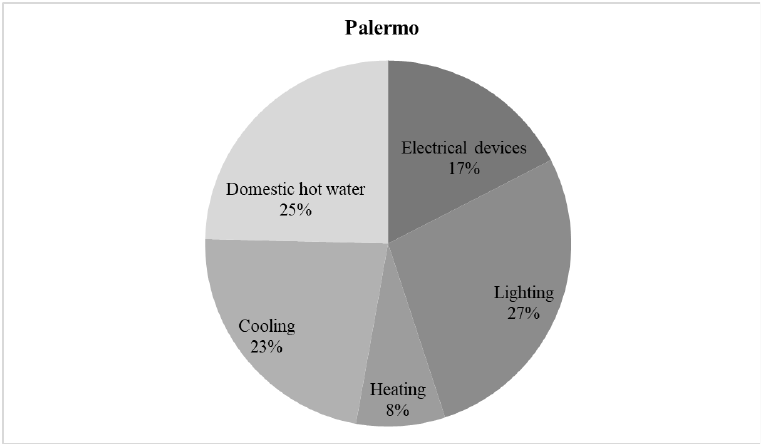
Figure 6. Entire yearly demand of primary energy (kWh/m 2 y) for the three analysed solutions in the case of Palermo. Energies 2020 , 13 , x FOR PEER REVIEW